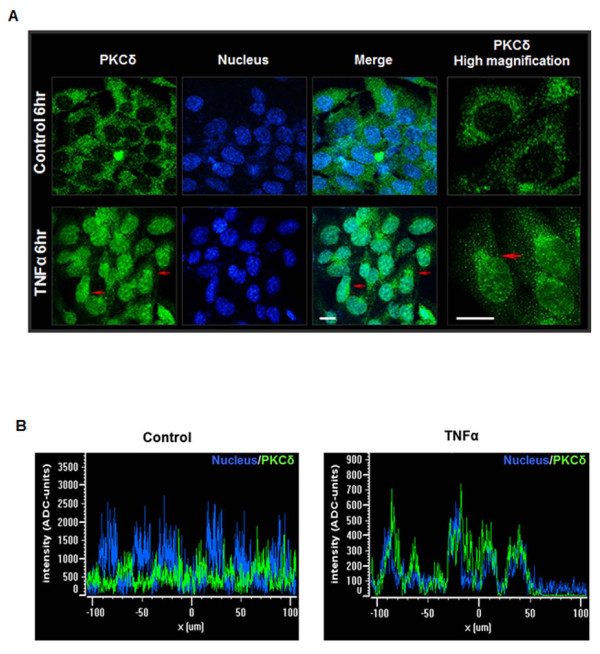
Protein kinase Cδ (PKCδ) translocates to the nucleus during tumor necrosis factor (TNF) treatment. (A) Confocal imaging of PKCδ localization. N27 cells were treated with TNF for 6 h and processed for immunocytochemistry using a rabbit polyclonal antibody that recognizes both the native and cleaved form of PKCδ. An Alexa-488 dye-tagged secondary antibody was used to visualize PKCδ (green), and the nucleus was stained using the TOPRO-3 dye (blue). In untreated controls (top panel), PKCδ was distinctly localized to the cytosol. In TNF-treated cells (lower panel), a distinct localization of PKCδ to the nucleus and the perinuclear region is seen. Scale bars are 20 microns. High magnification images (right panel) of PKCδ immunofluorescence staining in N27 cells showing PKCδ accumulation within the nucleus and at distinct spatial locations at the perinuclear region following TNF treatment (red arrows). Representative images are shown; experiments were repeated three times using different secondary antibodies for validation. (B) Fluorescence spatial intensity plots along a representative XY plane for PKCδ localization (green channel) and the nucleus (blue channel) were obtained using the Nikon EZC1 image analysis software. Control images show a distinct spatial localization of green and blue fluorescence intensities in the XY plane indicative of cytosolic PKCδ localization. In TNF-treated cells a spatial colocalization of green and blue fluorescence signals is evident indicating nuclear translocation of PKCδ.